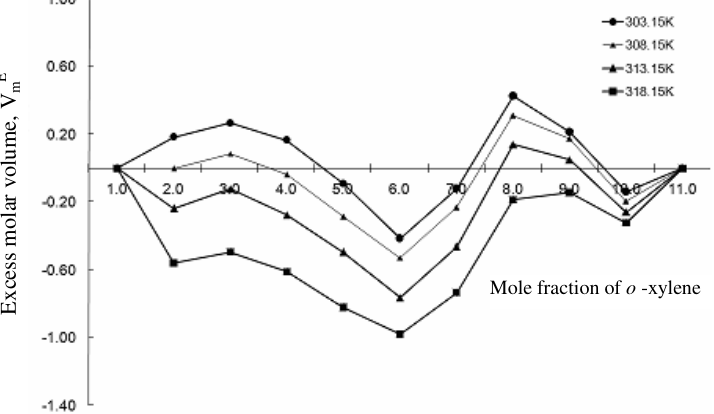
Figure 3. Variation of excess free length with mole fraction at different temperatures.